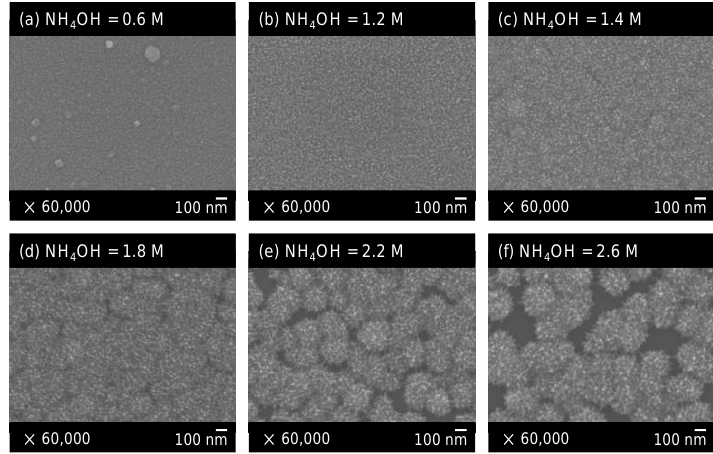
Figure 1. Surface morphologies of Zn(Se,OH) films deposited with a constant selenourea concentration of 0.03 M, and the ammonia concentrations of ( a ) 0.6 M; ( b ) 1.2 M; ( c ) 1.4 M; ( d ) 1.8 M; ( e ) 2.2 M and ( f ) 2.6 M.